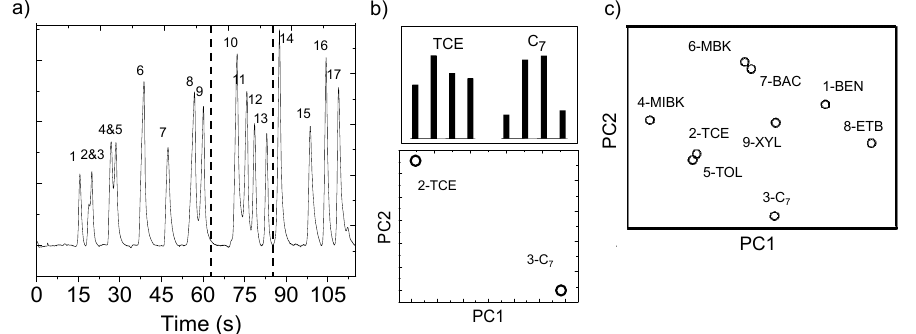
Figure 2. ( a ) 17-VOC chromatogram from the EOE sensor of the PEMM; ( b ) Response patterns and PCA plot for TCE and C7 (overlapping peaks 2, 3); ( c ) PCA plot of cmpds in the 1st retention time window (15–60 s). Conditions: ~100 ppm of each VOC; 1-min sample @5 mL/min; μ PCF: 225 °C;